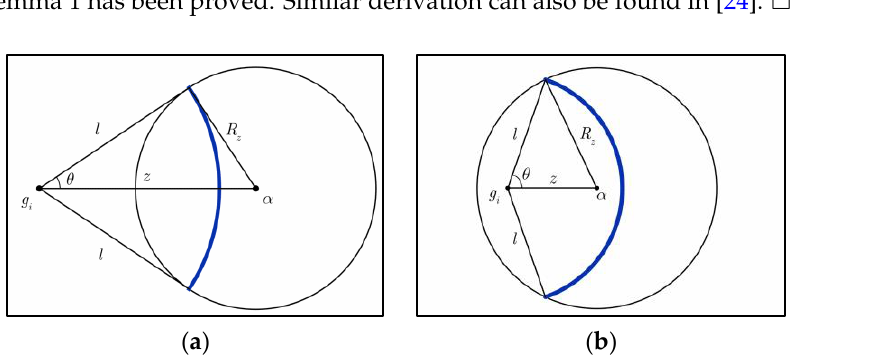
Figure 3. Probability of the nodes which are l -distance from z R  ; ( b z